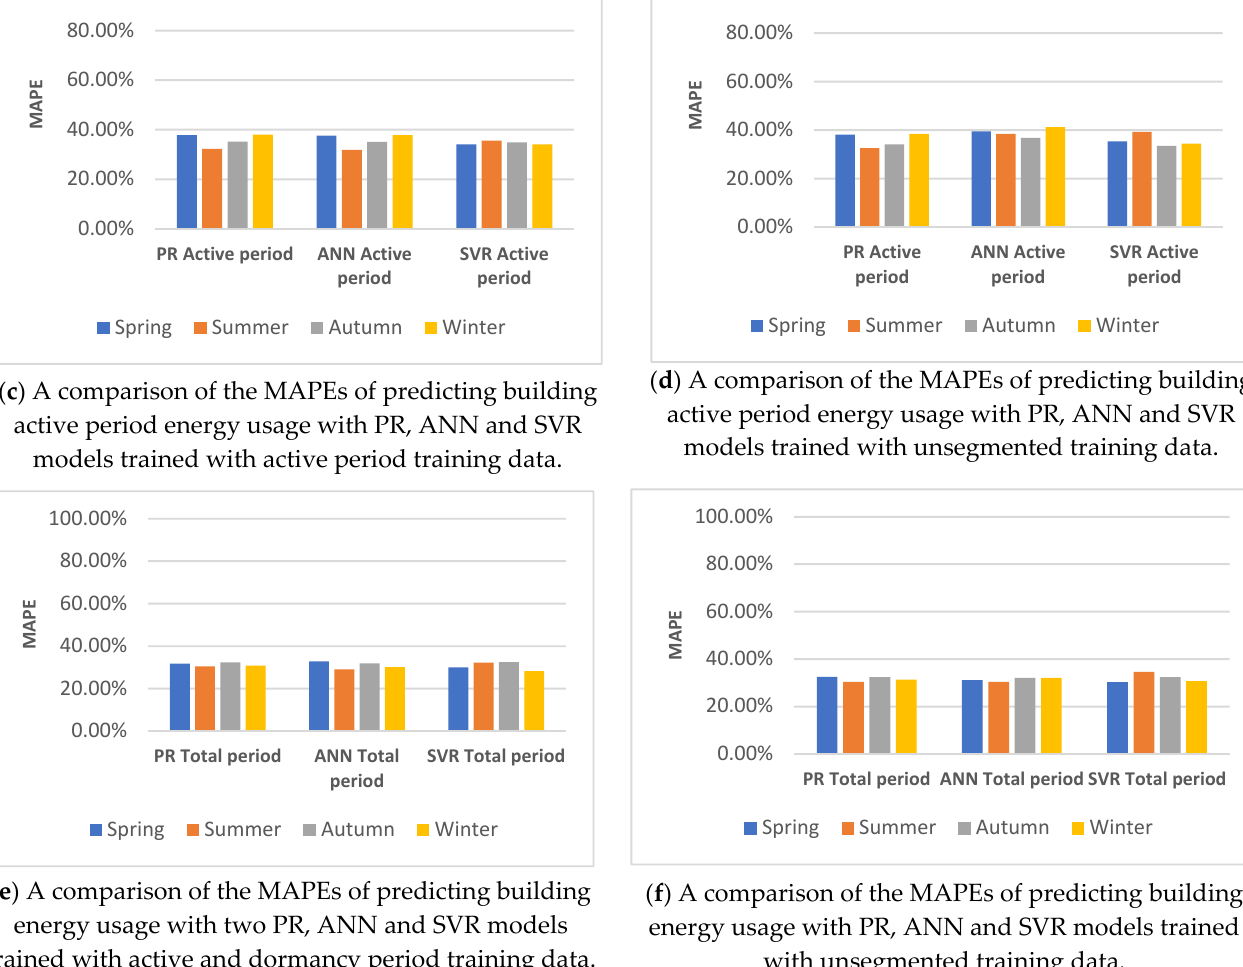
( f ) A comparison of the MAPEs of predicting building energy usage with PR, ANN and SVR models trained with unsegmented training data. Figure 20. A comparison of active/dormancy segmented machine learning techniques monthly MAPE.